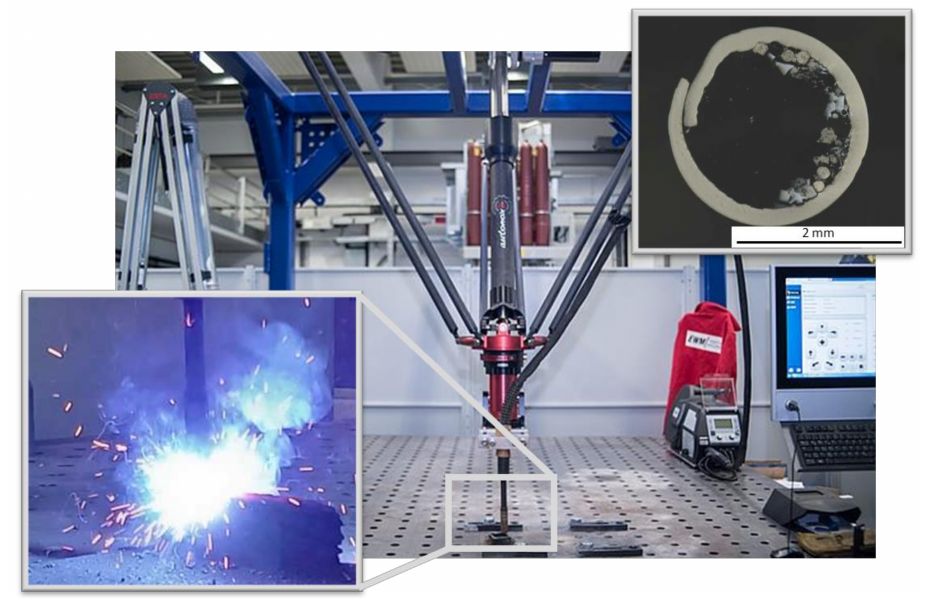
Figure 2. Wall-like structure during additive manufacturing